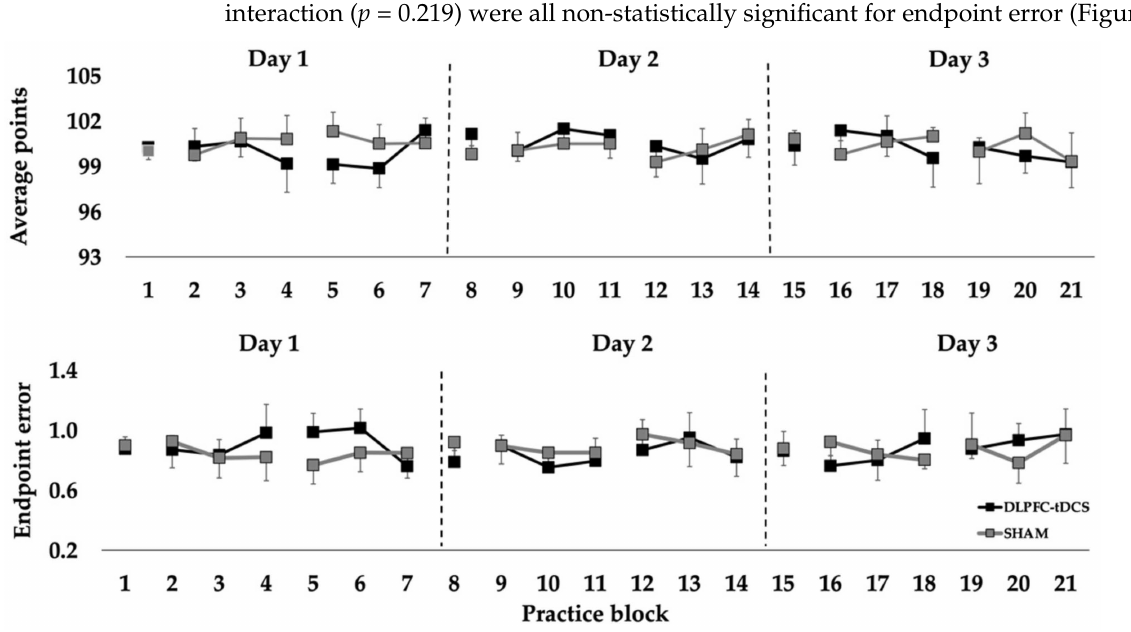
Figure 2. Points and endpoint error in the rifle shooting task in the pre-test, practice, and post-test blocks over 3 consecutive days for the DLPFC-tDCS and SHAM conditions. Each point represents the average of a block of 10 rifle shooting trials.